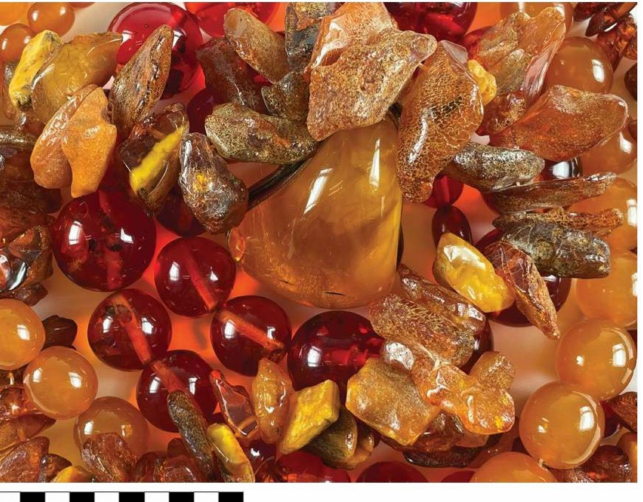
Figure 1. Digital image of various types and shapes of amber. Scale in cm.